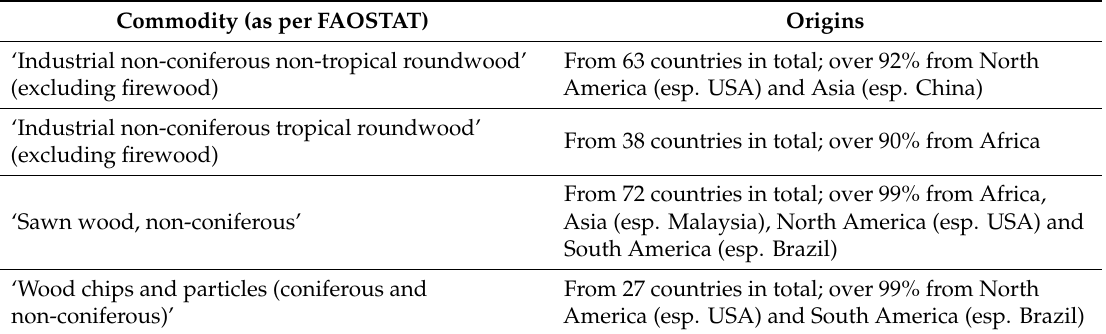
From 63 countries in total; over 92% from North America (esp. USA) and Asia (esp. China) From 38 countries in total; over 90% from Africa From 72 countries in total; over 99% from Africa, Asia (esp. Malaysia), North America (esp. USA) and South America (esp. Brazil) From 27 countries in total; over 99% from